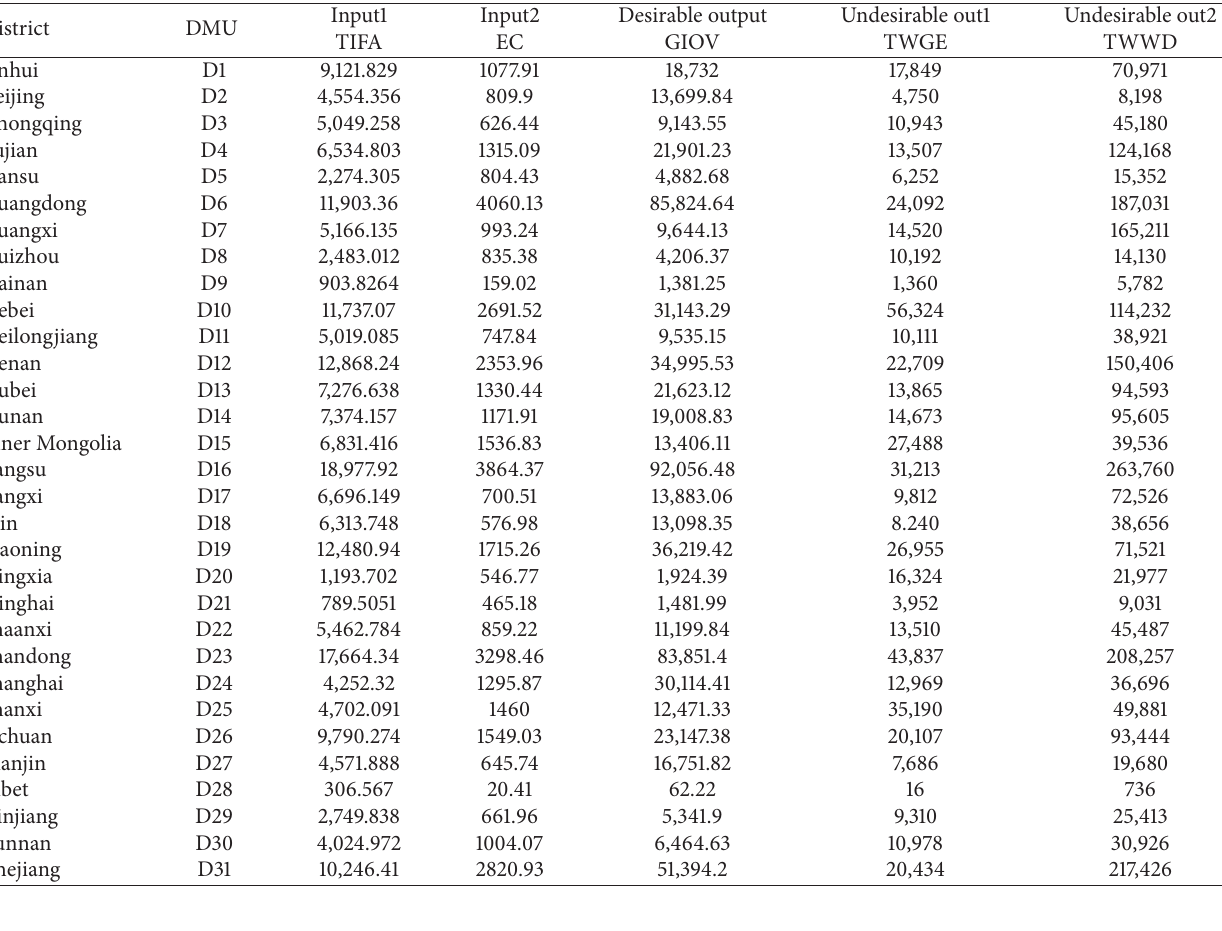
Table 1: Data set of industry of China in